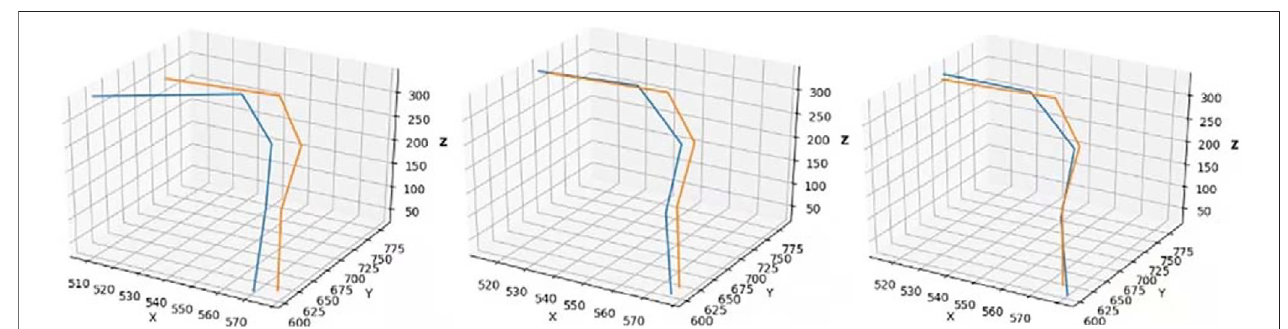
FIGURE 8 | The training process of the soft arm in a certain round.